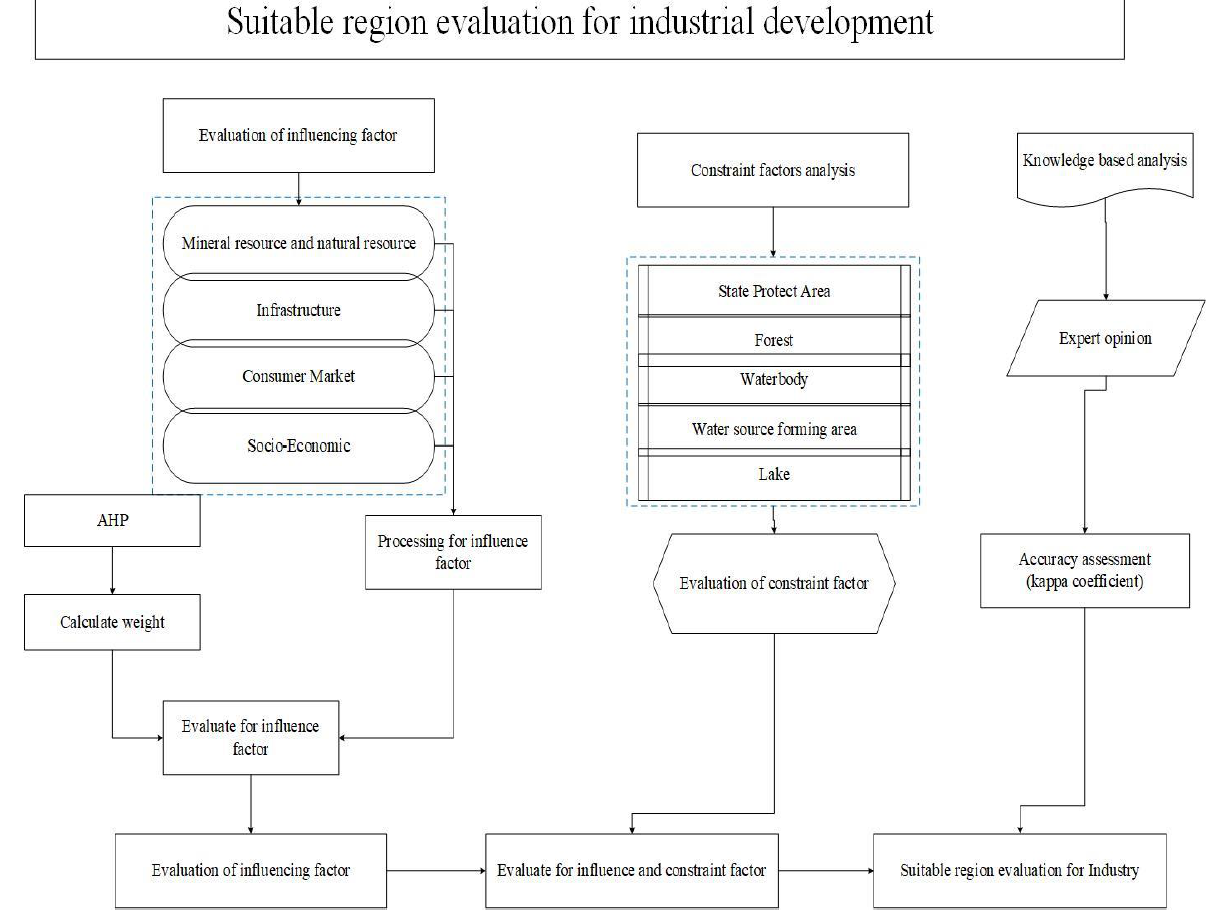
Figure 2. The approach of suitable location evaluation for the metallurgical and steel processing